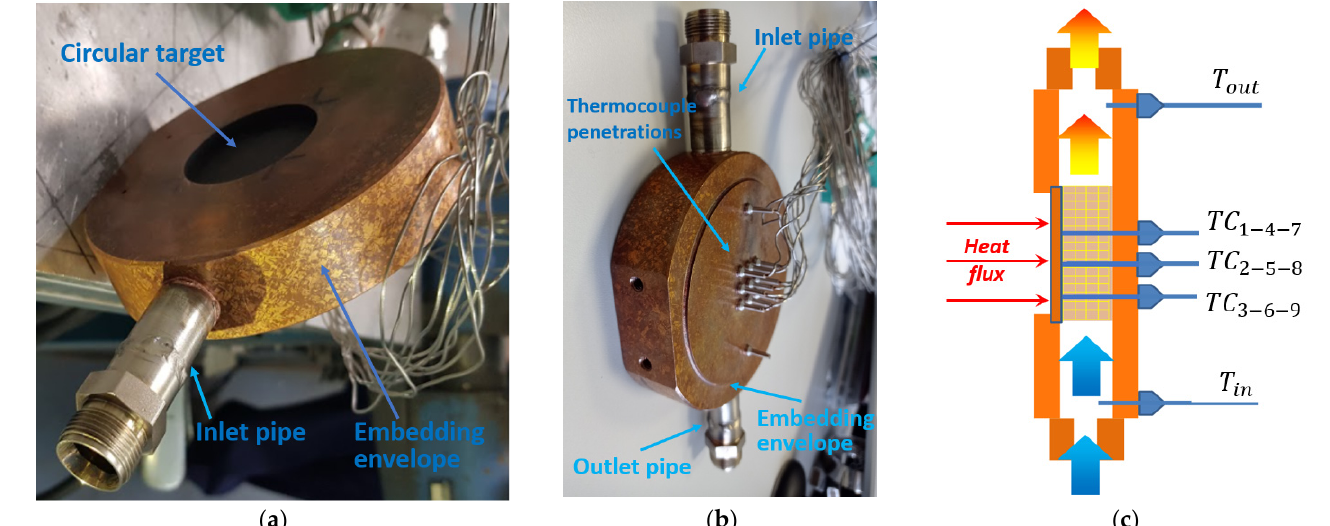
Figure 4. Cavity planar mock-up equipped with RR: ( a ) front/side view with the circular heated target in evidence, ( b ) back view with the instrumentation (thermocouples), ( c ) sample cross section.